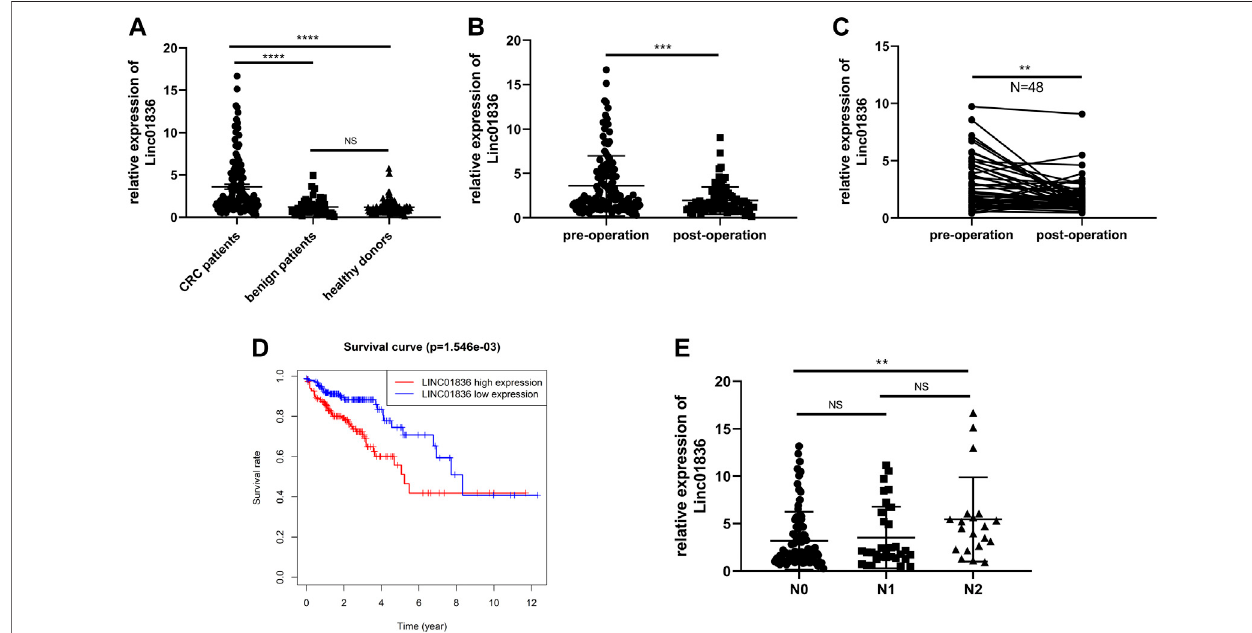
FIGURE3| Serum Linc01836serving asabiomarkerforearlydiagnosisand cancersurveillance. (A) Theexpression level ofserum Linc01836incolorectal cancer (CRC) patients ( n = 137), healthy donors ( n = 138), and patientswith benign colorectaldiseases ( n = 51). (B) The expression level ofserum Linc01836 inpreoperational CRC patients (n = 137) and postoperational CRC patients ( n = 82). (C) The expression level of serum Linc01836 in 48 pairs of CRC patients before and after surgical resection. (D) Survivalcurve veri fi edtheprognosticvalue ofLinc01836. (E) Theexpression level ofserum Linc01836inCRC patients withdifferentstages oflymph node metastasis. * p < 0.05, ** p < 0.01, *** p < 0.001, **** p < 0.0001, NS p >